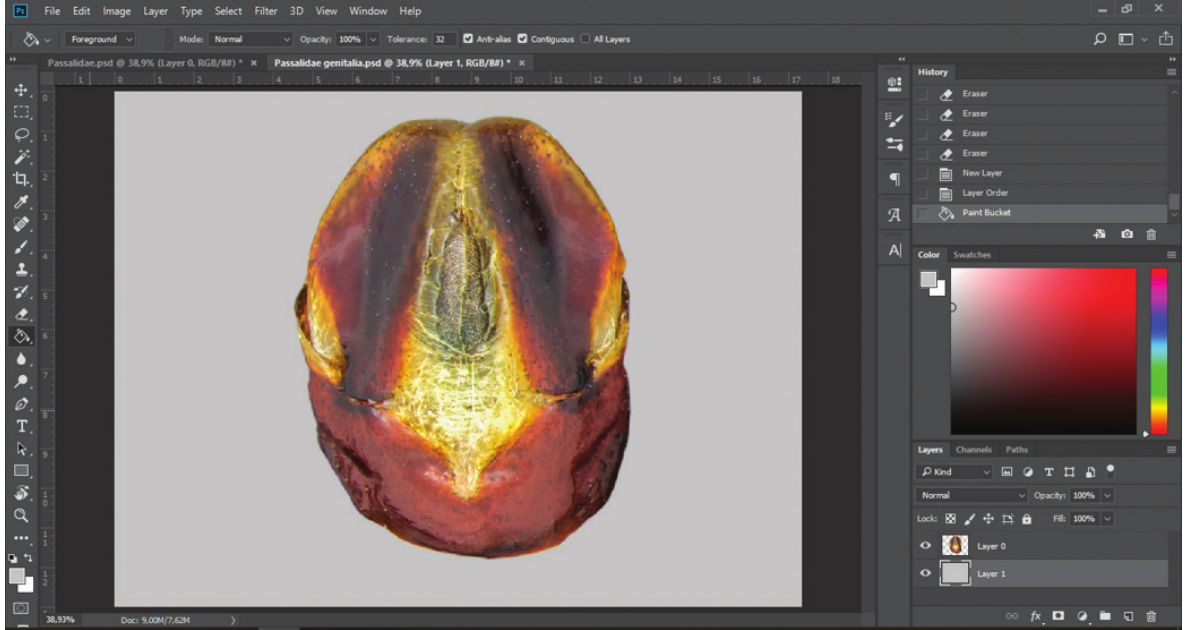
Figure 18. Image with completely erased background and a new coloured layer serving as a completely new homogeneous